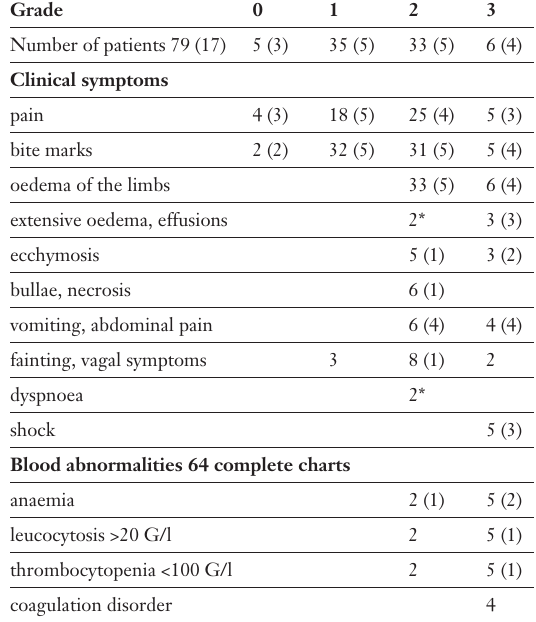
Table 3 Clinical and biologi- cal symptoms in 79 adults and 17 children (numbers in brackets) bitten by Vipera